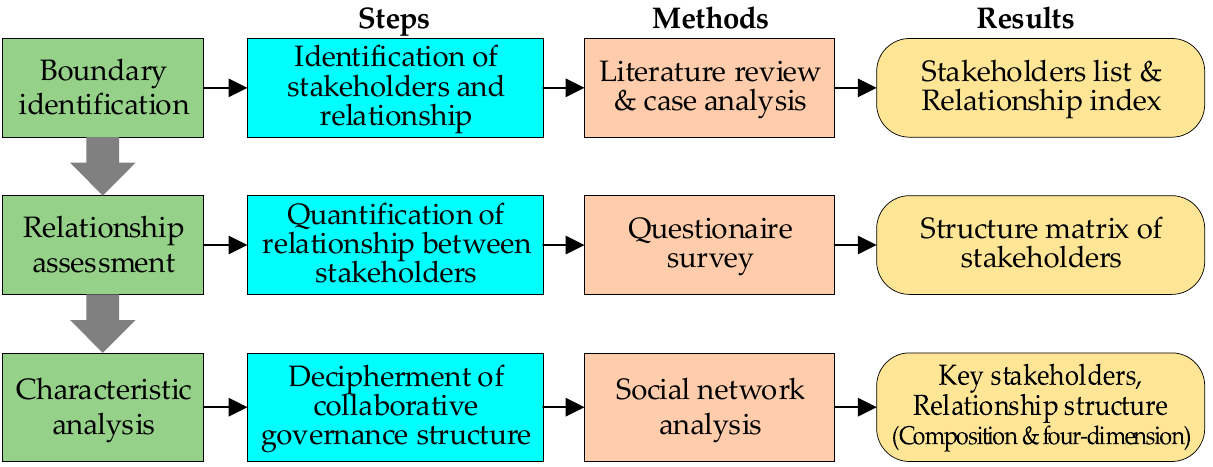
Figure 1. The research framework from a social network perspective.